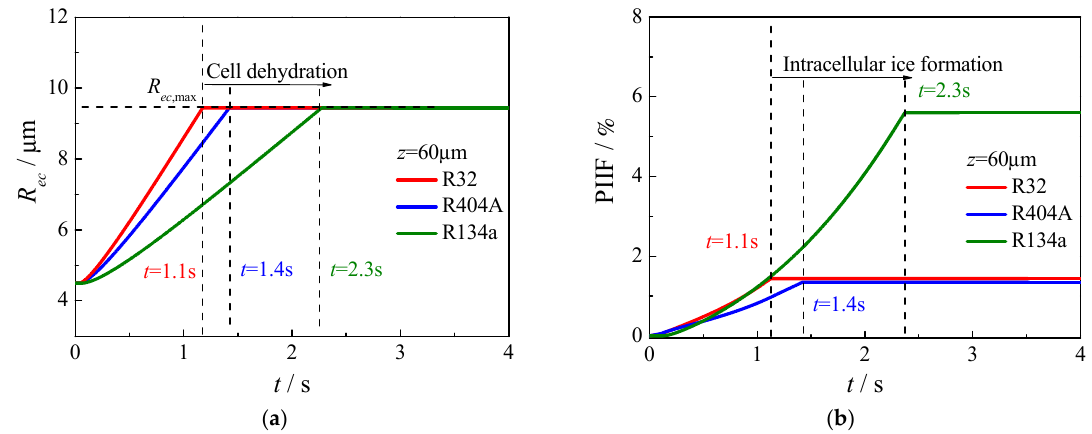
Figure 18. Time-varied ( a ) radius of extra-cellular space and ( b ) probability of IIF during CSC.